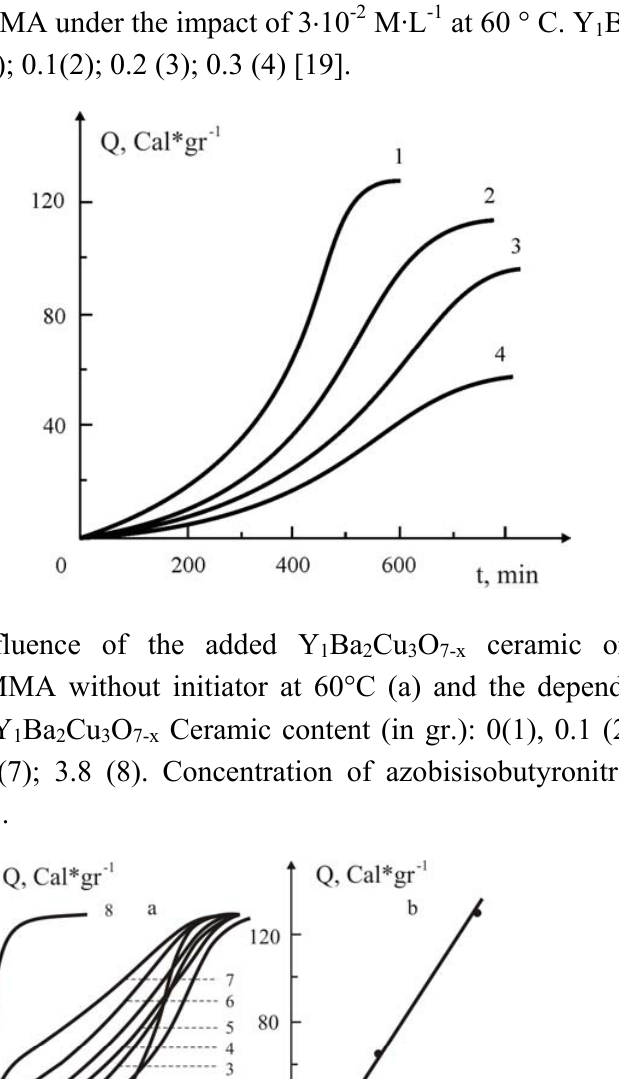
Ba Cu O Ceramic 1 2 3 7-x